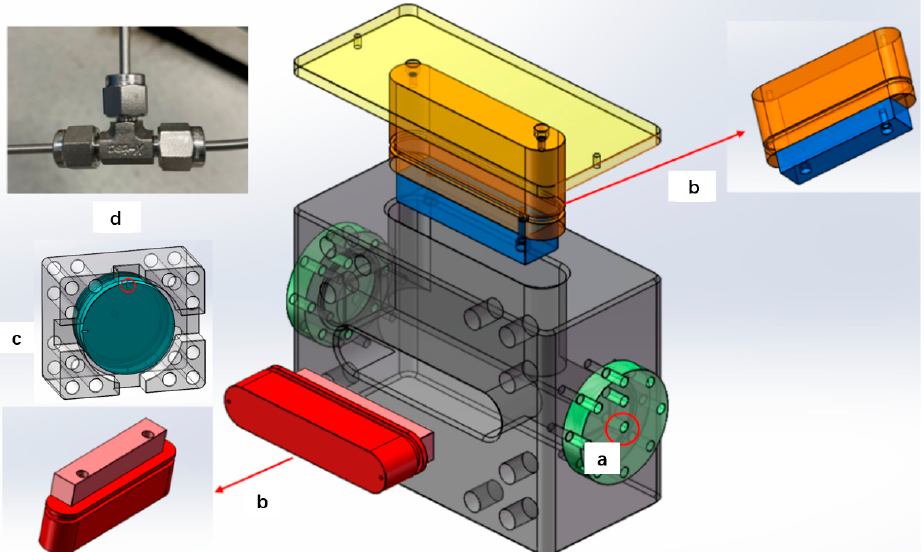
Figure 3. Schematic of the new conductivity cell: (a) sealing assembly, (b) hydraulic load frame and side piston, (c) lateral load frame and displacement measurement device, and (d) three-way connector.